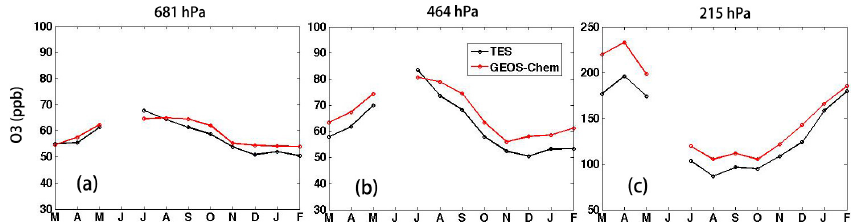
Figure 3. Monthly mean O 3 concentration for lower free troposphere (681hPa), middle free troposphere (464hPa) and upper free troposphere (215hPa) in the period of March 2005–February 2006 over Middle Eastern Asia (blue box in Fig. 4) for TES O 3 retrievals and GEOS-Chem simulation (smoothed with TES averaging kernel and a priori). There is no TES data available in June 2005.